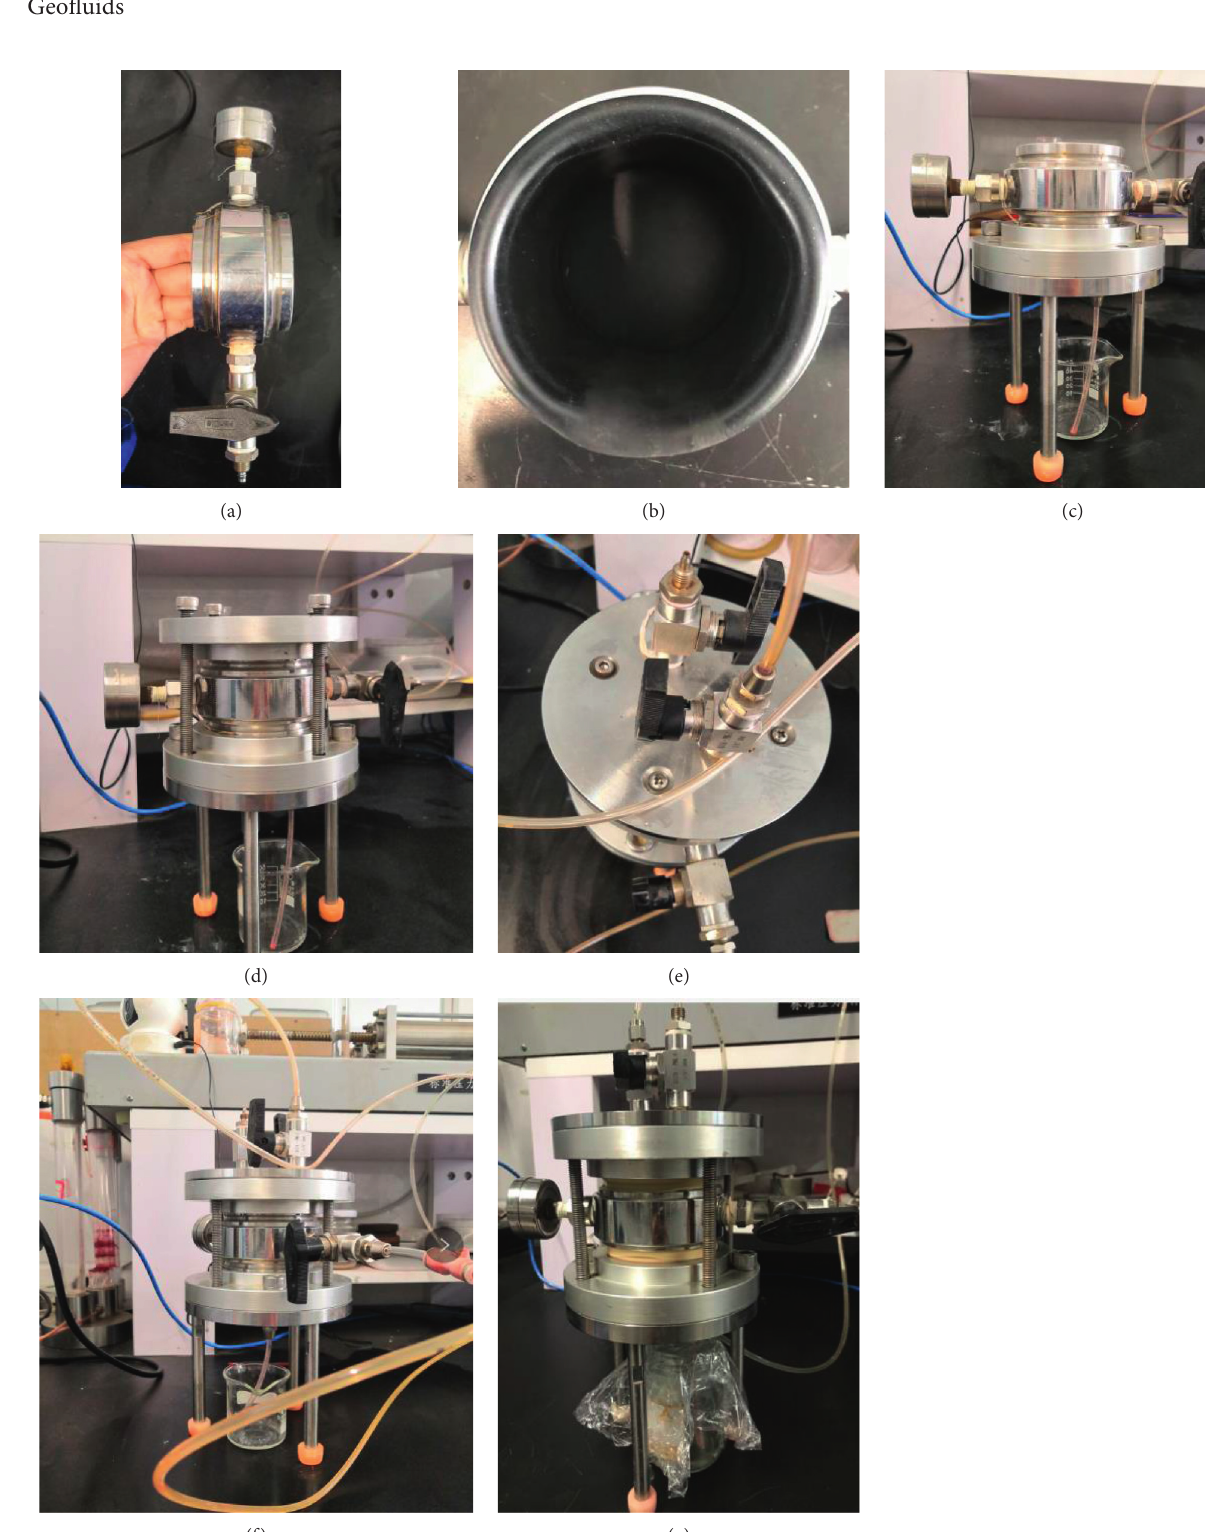
Figure 6: Improved rigid wall permeability test device and operation steps. (a) Sample chamber. (b) Set up rubber membrane. (c) Place the soil sample chamber on the base. (d) Adjust the confining pressure to place the soil sample to be tested. (e) Tighten the bolts around the top cover. (f) Open the top cover vent valve for venting. (g) Conduct a permeability